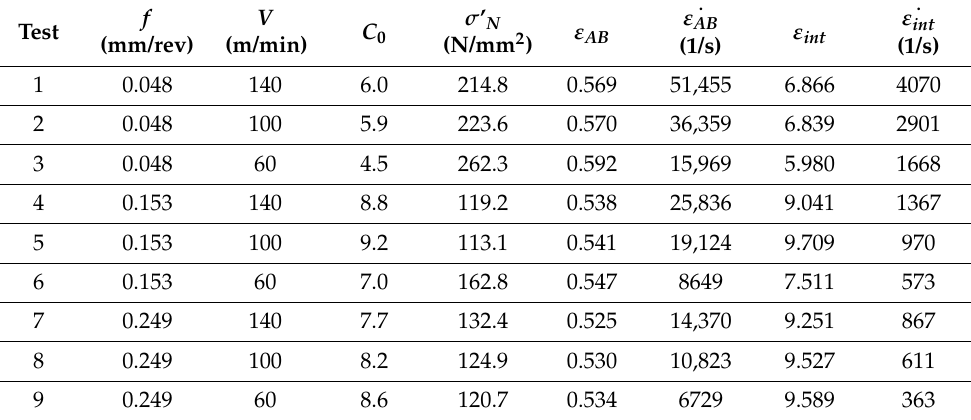
Table 12. The values determined for a p = 1.77 mm, α = 15 ◦